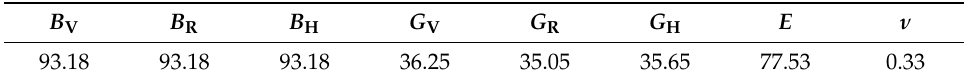
Table 1. The calculated bulk moduli ( (cid:1828) (cid:2906) , (cid:1828) (cid:2902) and (cid:1828) (cid:2892) , in GPa), shear moduli ( (cid:1833) (cid:2906) , (cid:1833) (cid:2902) and (cid:1833) (cid:2892) , in GPa), Young’s moduli ( (cid:1831) , in GPa), and Poisson’s ratio ( (cid:2021) ) of CAO.